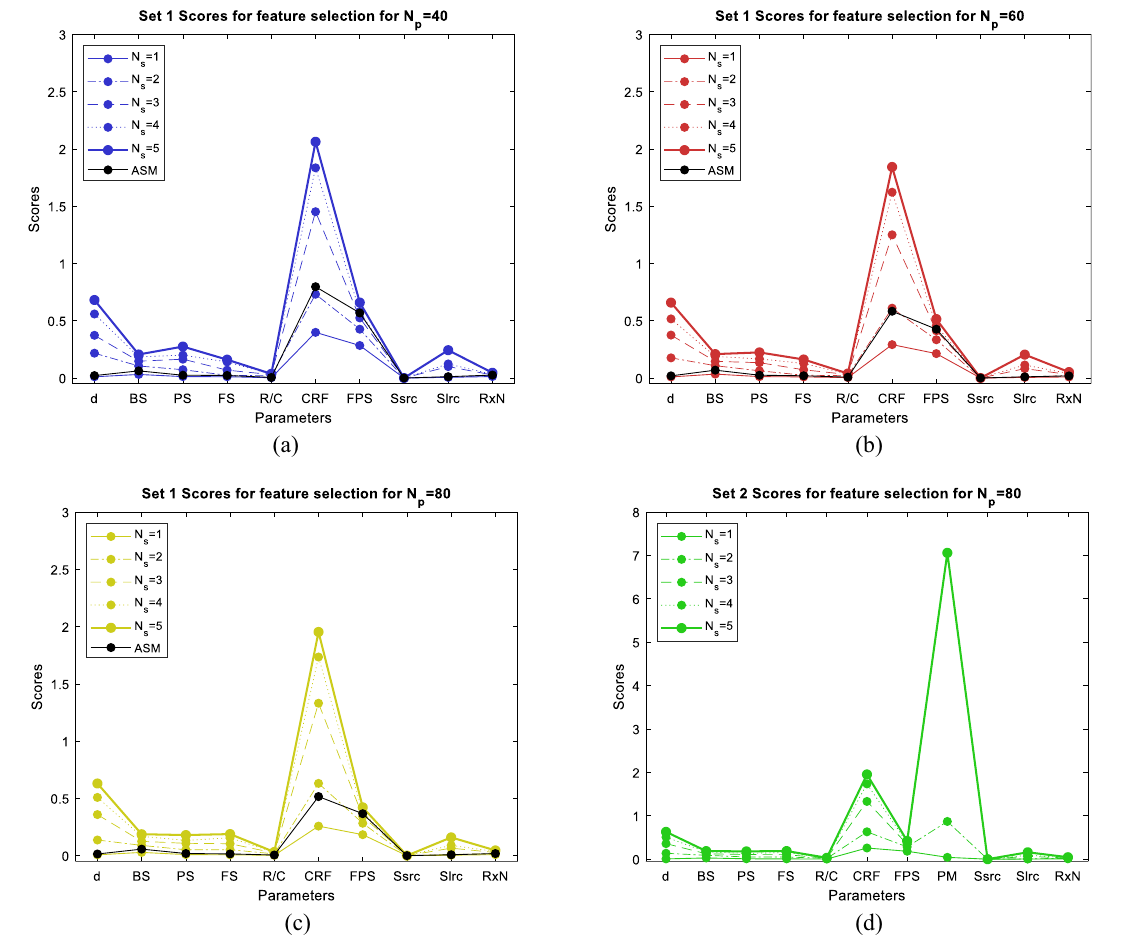
Figure 5. Activity scores for feature selection ASFS and Variance/STD scores for feature selection VSFS for N s = { 1, 2, 3, 4, 5 } ( a ) Set 1 for N p = 40 , ( b ) Set 1 for N p = 60 , ( c ) Set 1 for N p = 80 ( d ) Set 2 for N p = 80